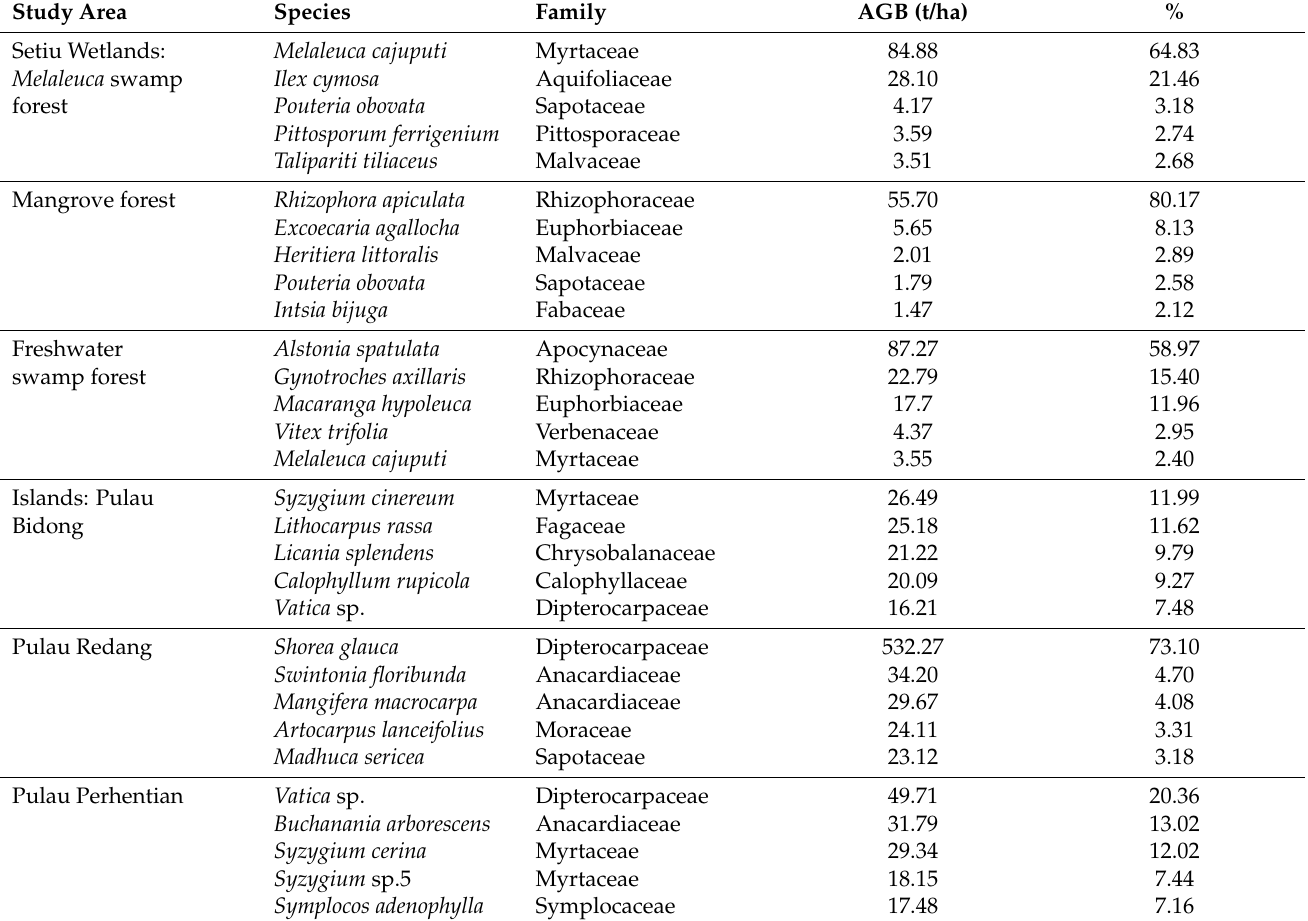
Table 5. List of five species that contribute to the highest amount of above-ground biomass